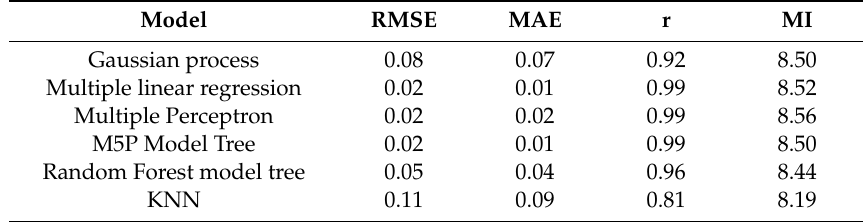
Table 8. Summary of performance of multiple ML models with training data from 2006 to 2012.